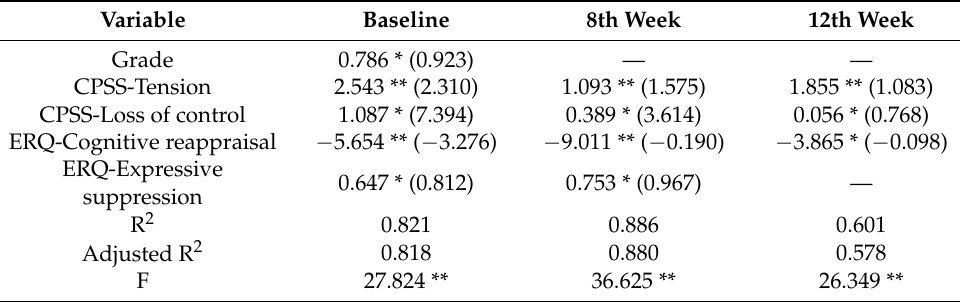
Table 7. Stepwise regression analysis results of fitness dance group. Variable